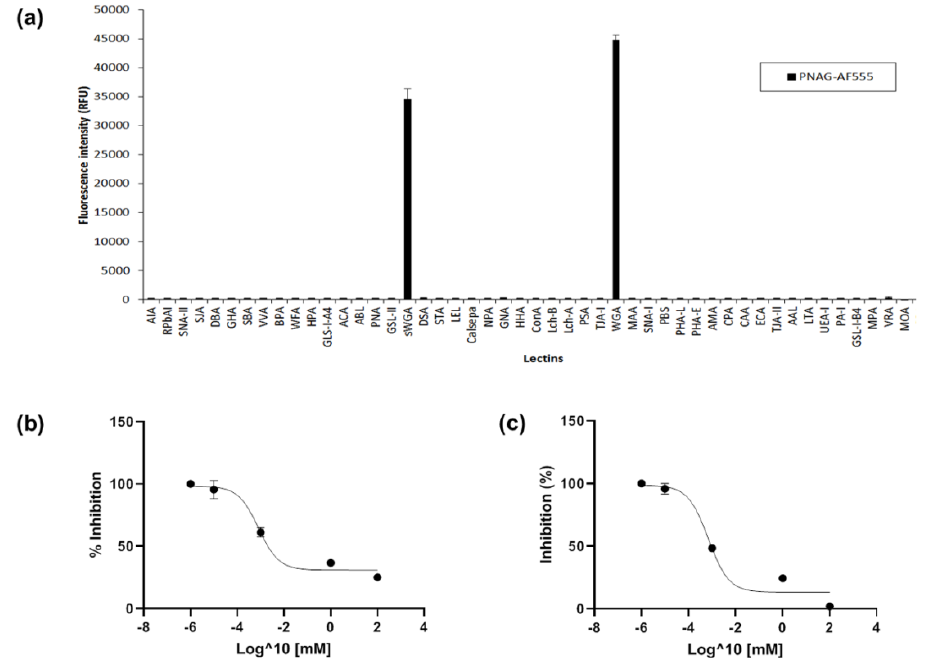
Figure 2. Lectin recognition of PNAG alone. ( a ) Lectin microarray profile of fluorescently labelled PNAG purified from S. aureus Mn8m culture. Bars represent the binding intensity of the mean of three experiments with error bars of +/-1 standard deviation (SD) of the mean. ( b ) Nonlinear fit transformation of GlcNAc inhibition PNAG binding to sWGA intensity data. Data points are the mean of three experiments with error bars of +/-1 SD of the mean. ( c ) Nonlinear fit transformation of GlcNAc inhibition of PNAG binding to WGA intensity data. Data points are the mean of three experiments with error bars of +/-1 SD of the mean.